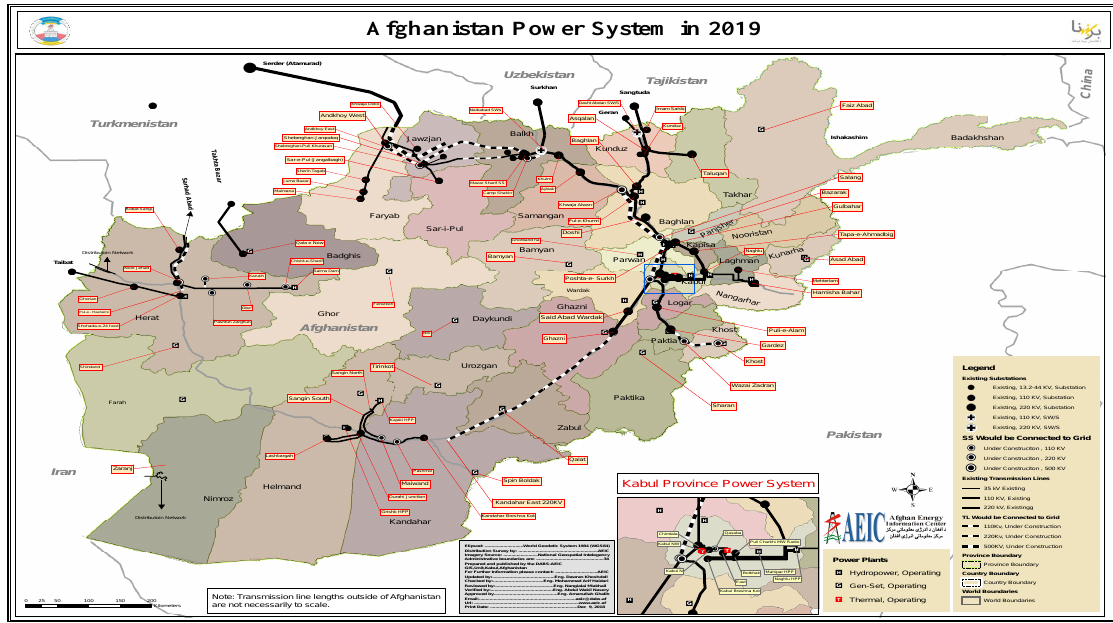
Figure 4. Existing Afghan Power System